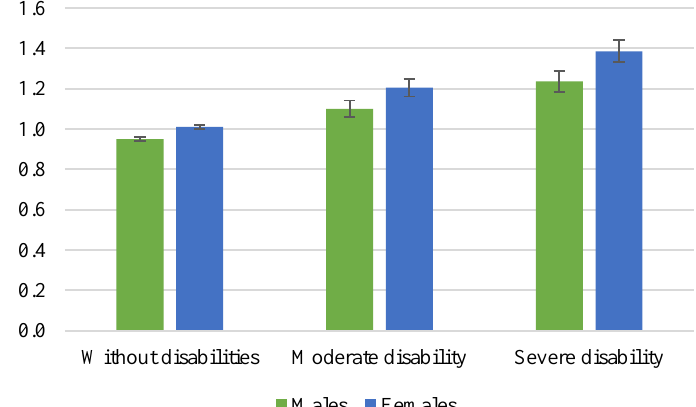
Figure 1. Mean loneliness scores by disability status for German males and females. Note: Weighted data. Individuals aged 16 or over. Confidence intervals ( p < 0.05) are shown. Number of observations: 20,841 males (18,131 without disabilities, 1415 with a moderate disability, and 1295 with a severe disability); 26,445 females (23,800 without disabilities, 1425 with a moderate disability, and 1220 with a severe disability). Source: SOEP data for the years 2013 and